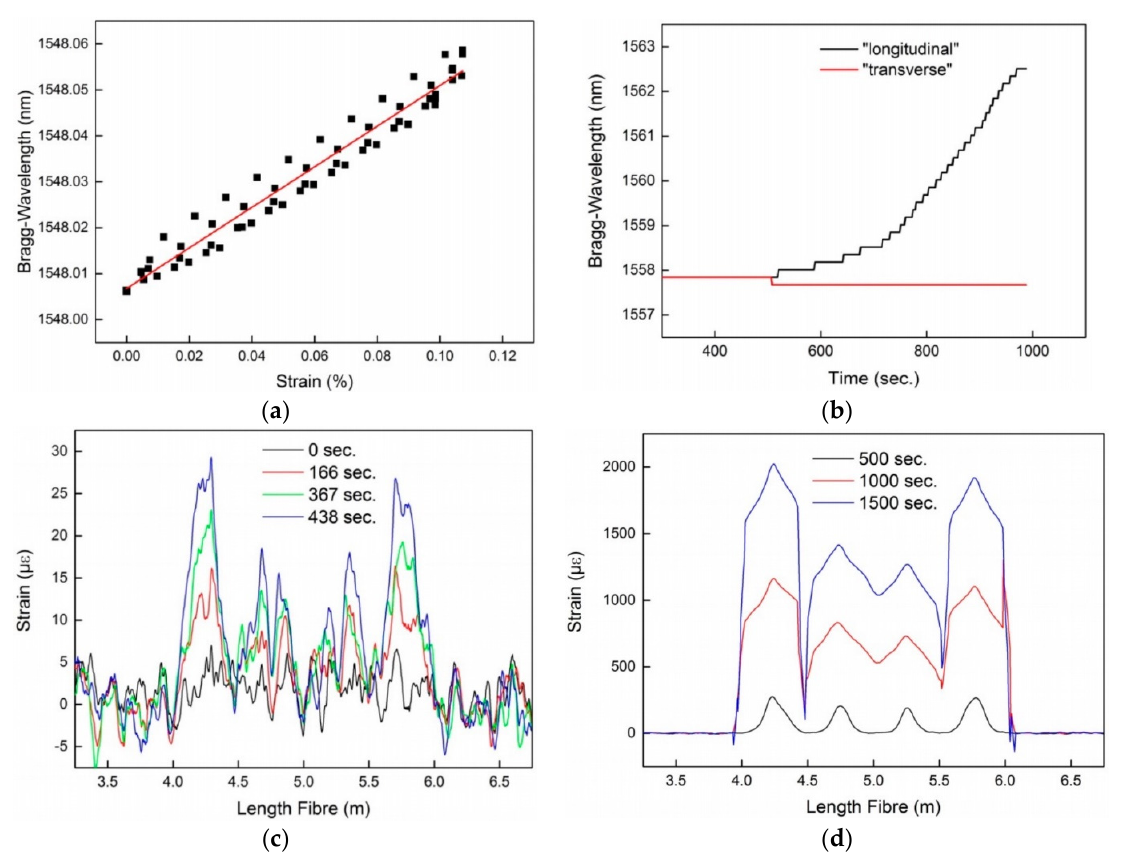
Figure 19. Obtained sensor response: Bragg-wavelength shift due to applied strain ( a ), discrimination between longitudinal and transverse applied strain ( b ), strain resolution of OFDR for low applied strains ( c ) and high applied strain ( d ) levels [97].